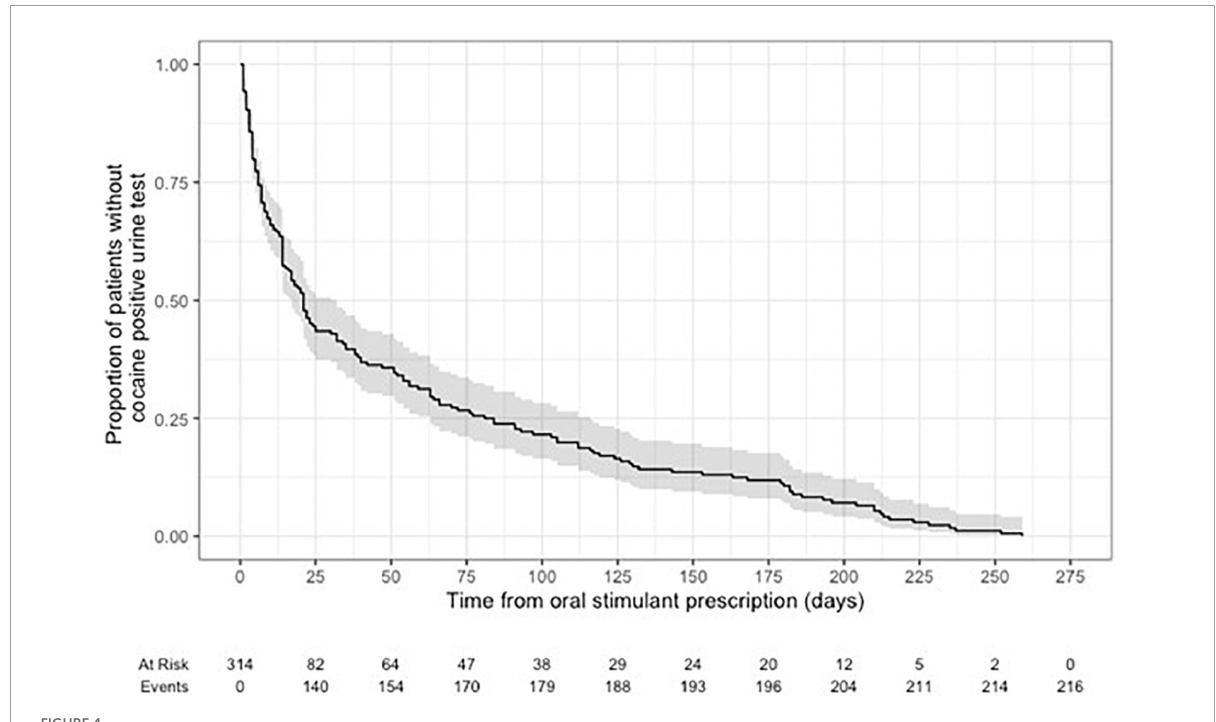
FIGURE4 Time to first positive cocaine urine test from the first prescription of oral